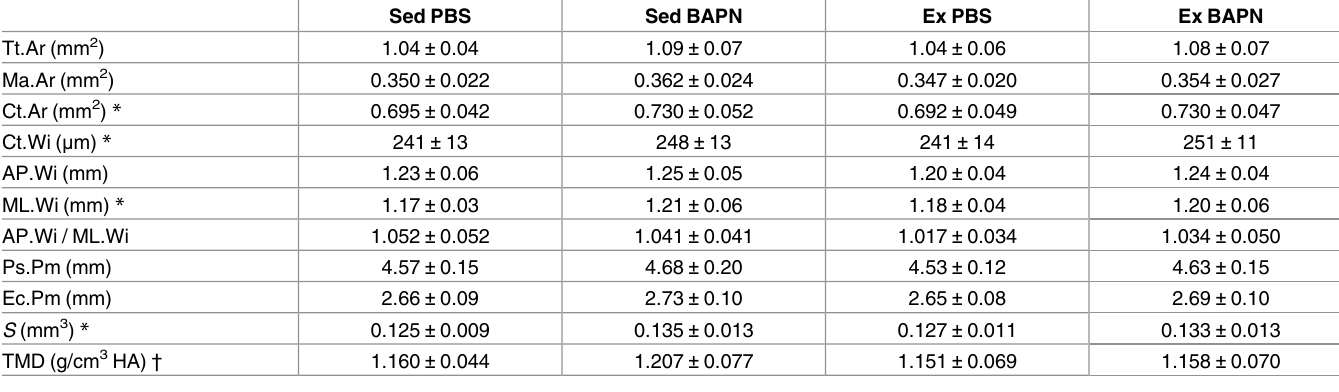
Table 4. Cortical analysis of tibial standard